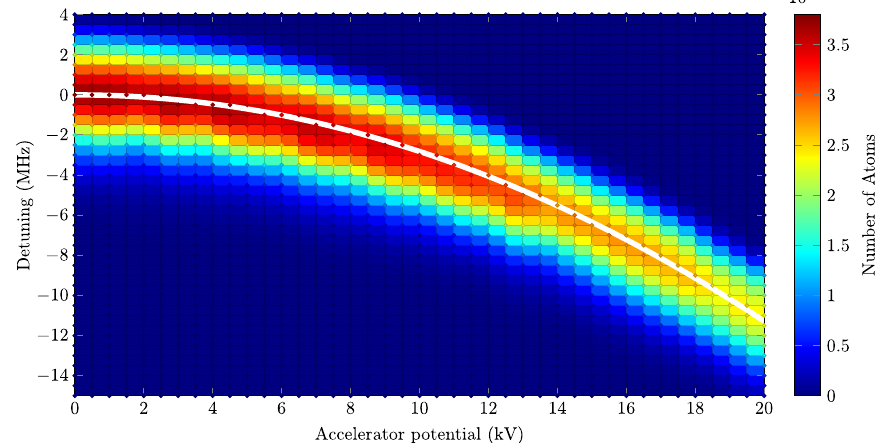
FIG. 9. Number of atoms in the MOT as a function of both accelerator potential and detuning with respect to the optimal detuning ( δ E ¼ 0 ¼ − 9 MHz) when no electric field ( E ¼ 0 ) is applied. The white line is a fit with theory and results in E ¼ 1 . 2 MV =